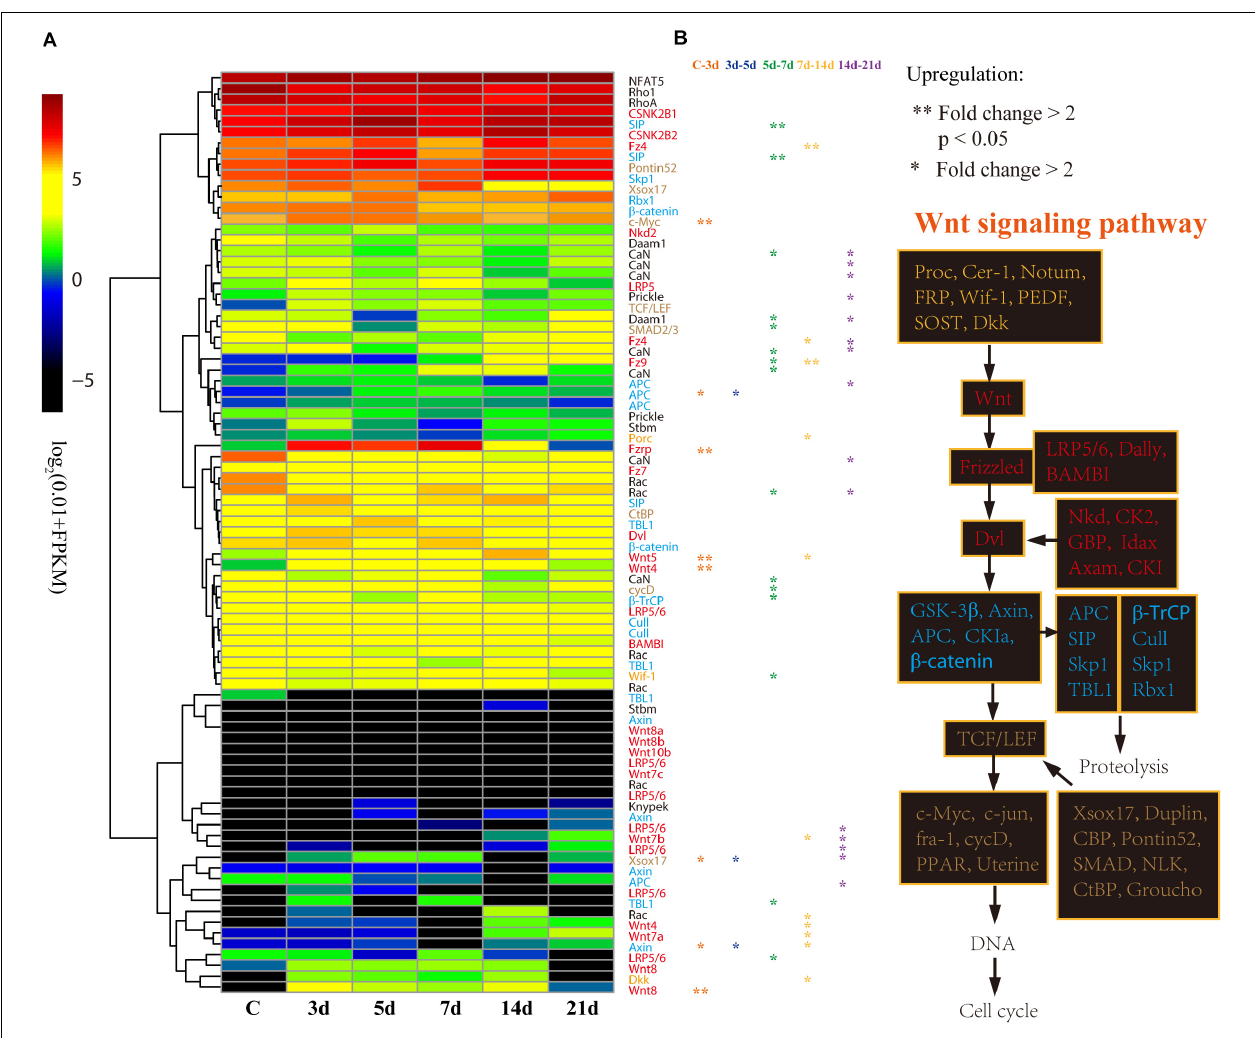
FIGURE 5 | Differential expression analysis of Wnt signaling pathway genes. (A) Expression profiles of the DEGs at different intestinal regeneration time points: 0 (C), 3 day (3d), 5 day (5d), 7 day (7d), 14 day (14d), 21 day (21d). Genes with different colors are correspondent to the color of genes in the plot B. (B) Genes involved in Wnt signaling pathway. Genes from upstream to downstream of the Wnt signaling pathway are in different color.